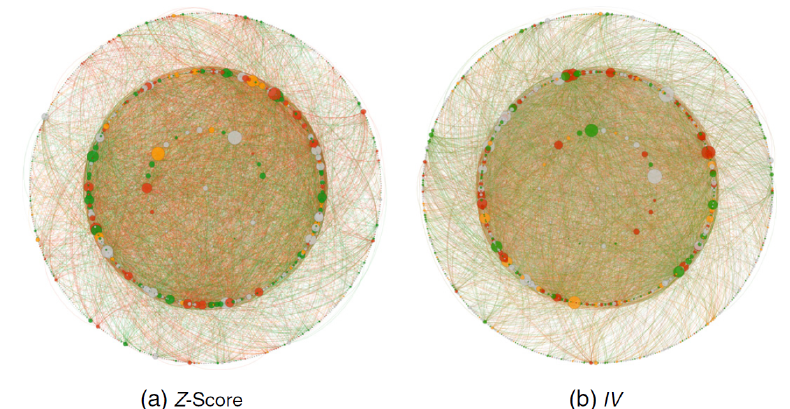
Figure 18. A three tier supply network of a major electronics manufacturer. The inner layer represents the primary supply dependants of the manufacturer, the middle layer represents the secondary dependants (primary dependants for the inner circle of dependants), and the third layer represents the tertiary dependants (primary dependants of the middle layer of dependants). Image courtesy of Basole and Bellamy